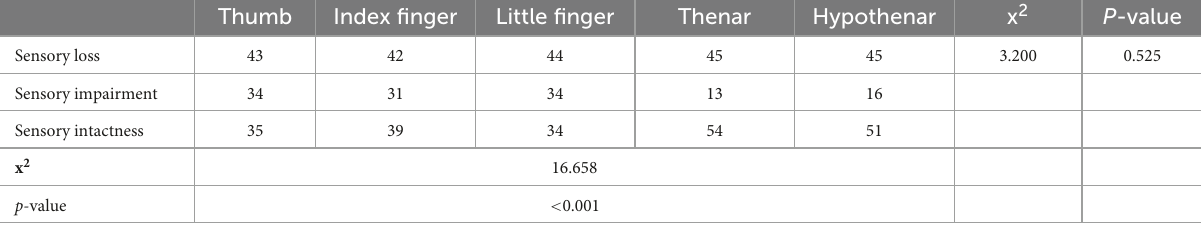
TABLE 4 Degree of 2-PD